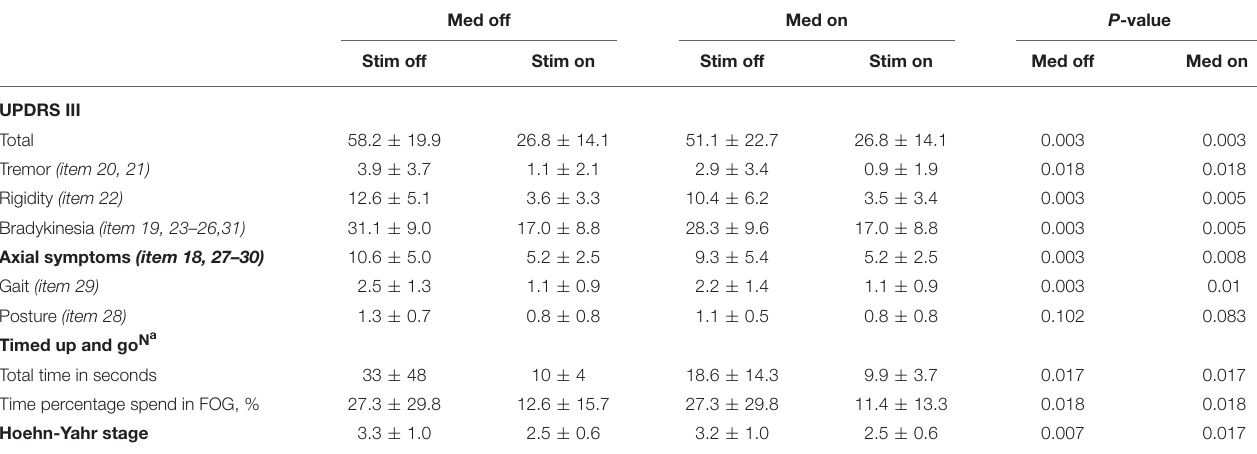
TABLE 1 | Motor symptom severity of patients ( N = 11) before and after STN-DBS*.